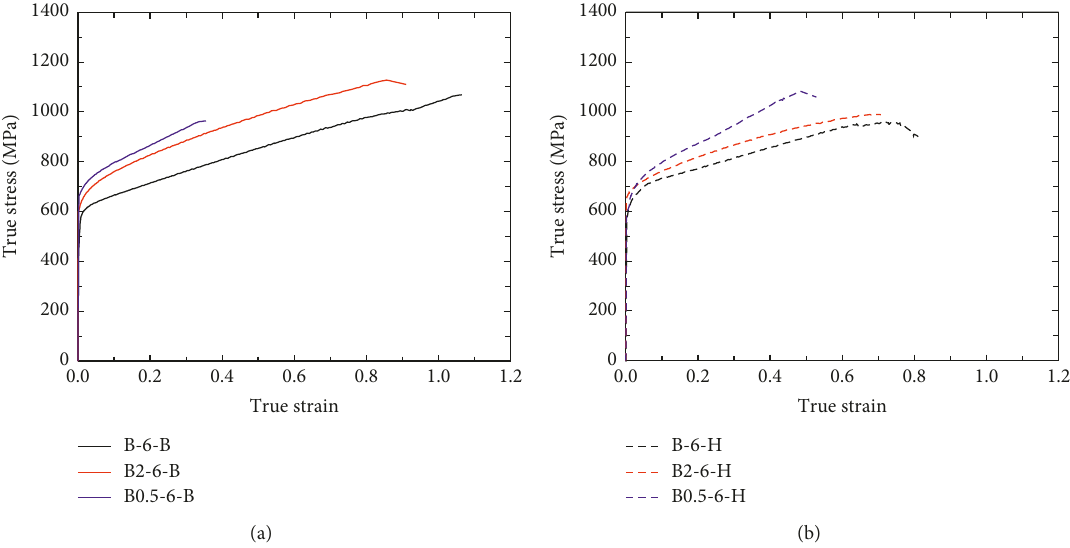
Figure 11: Stress-strain curves under different triaxial stresses. (a) BMZ. (b) HAZ.